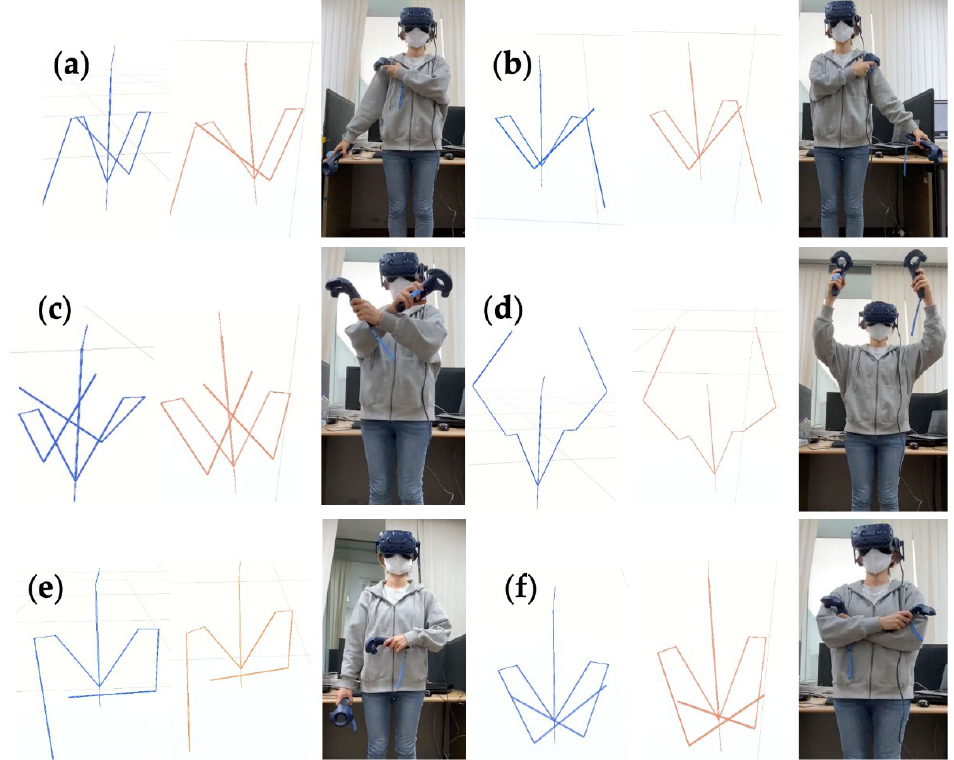
Figure 7. Comparison of our results in blue ( left ) and inverse kinematics (IK) in red ( middle ) from the user ( right ) ( a ) left-hand blocking, ( b ) right-hand blocking, ( c ) sway motion, ( d ) lift motion, ( e ) right-hand in front motion, and ( f ) folded arms motion generation.